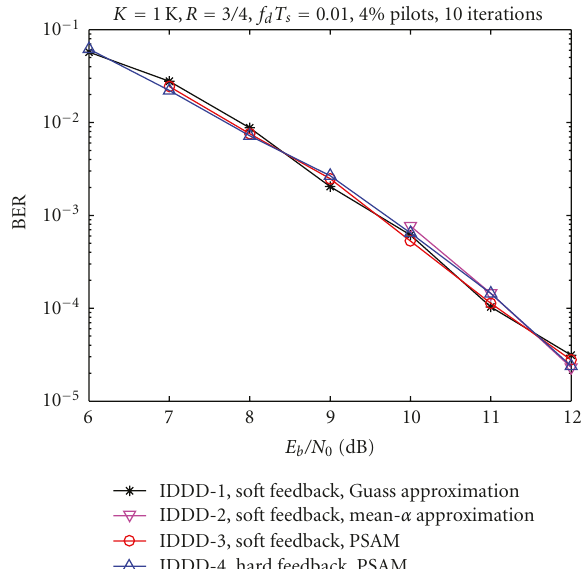
Figure 12: Comparison of BER performance for several noncoher- ent receiver strategies on correlated Rayleigh channels with f d T s = 0.01. Code rate 0.75, data block size 1K, 4% of bandwidth expansion, filter length 65, 10 (global) iterations each with 4 (local) iterations for the outer